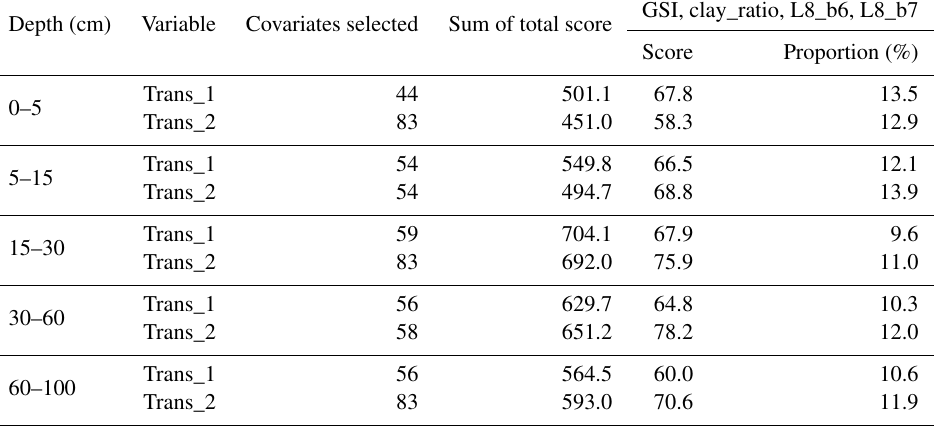
Table A1. Representation of importance scores for satellite-derived covariates. GSI: grain size index, L8 b7: Landsat 8 band 7, L8 b6: Landsat 8 band 6.